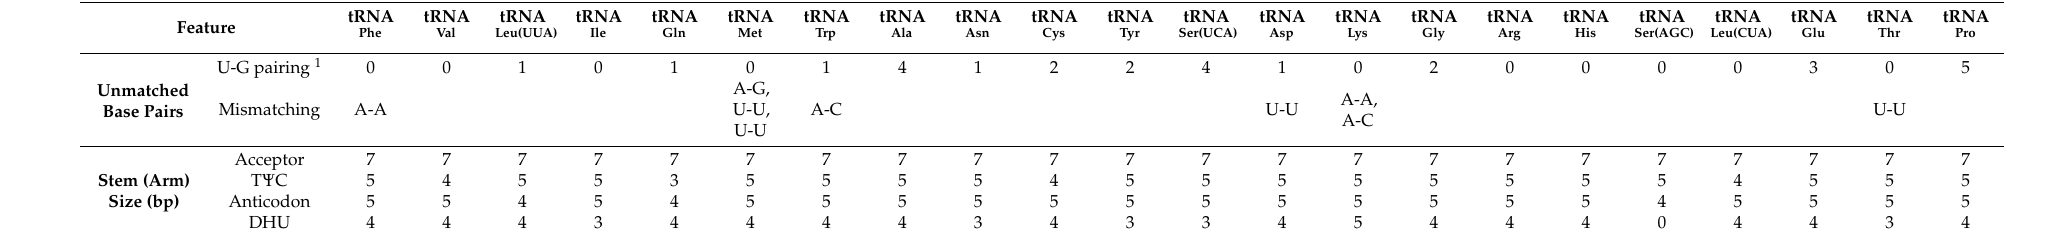
Table 4. Characteristics of the secondary structure of the mitochondrial tRNAs in European